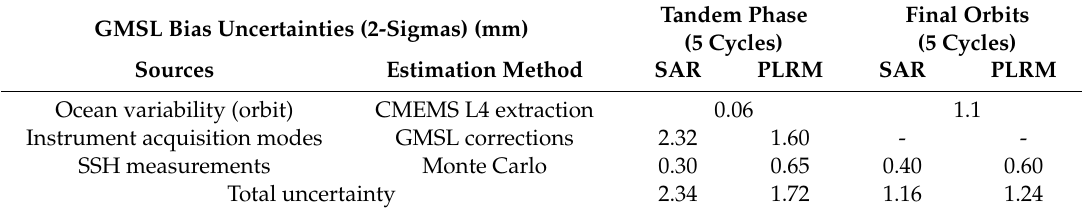
Table 2. GMSL bias uncertainty budget, comparisons between estimations on the tandem and final orbits.